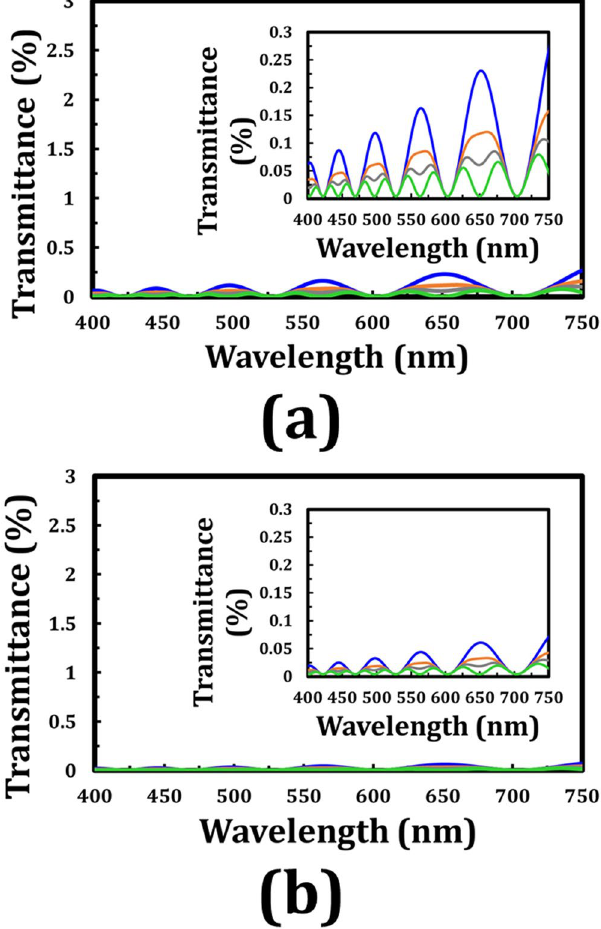
Figure 5. Simulated transmittance (1D-DIMOS) of the output beam through a tandem-2 φ -TNLC cell and an analyzer with its transmissive axis of 90° + 2 φ with respect to that of the polarizer ( β ) versus the wavelength of the input beam at different β angles with φ of ( a ) 45° and ( b ) 22.5°. Blue, orange, gray, and green curves represent the different β angles of 0°, 22.5°, 30°, and 45°, respectively. Insets evidently show the details of the spectra. The refractive index dispersion of the adopted LC (E7) for these theoretical analyses is not